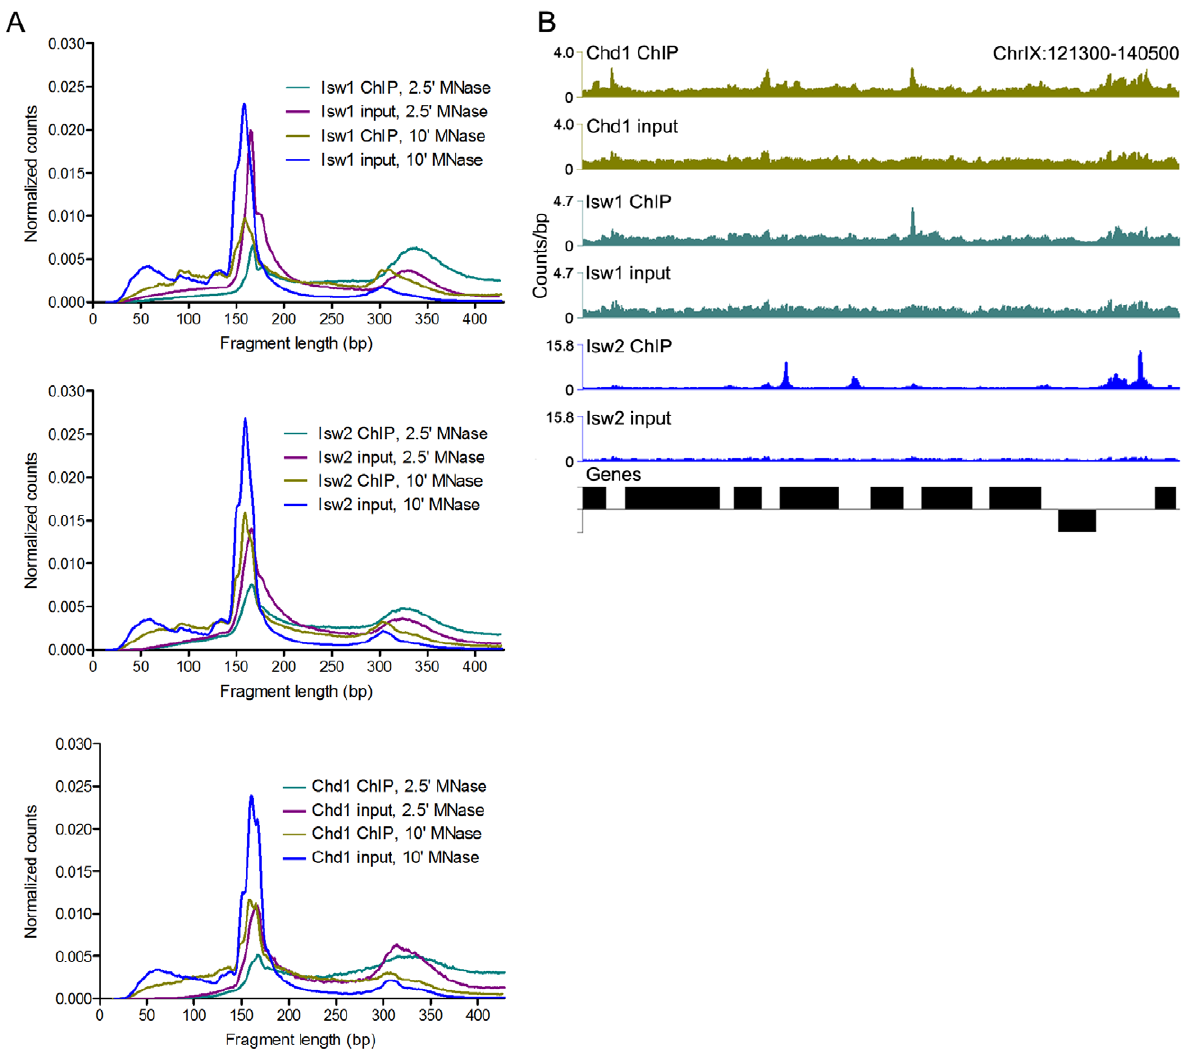
Figure 1. N-ChIP-seq localizes ISWI and CHD remodelers throughout the genome. (A) Size distributions of mapped paired-end 2.5 9 and 10 9 MNase-digested wild-type Isw1, Isw2, and Chd1 ChIP and input fragments. Slight variations in the amount of supernucleosomal ( . 251 bp) fragments are attributable to minor variation in the degree of MNase digestion for each sample, as evidenced by slight differences in the nucleosomal maxima for each sample. (B) Binding profiles for 10 9 MNase-digested Isw1, Isw2, and Chd1 samples across a representative region of the genome. The number of paired-end reads overlapping each genomic position (counts/bp) is indicated on the Y-axis. See Figure S1 for additional remodeler binding profiles.